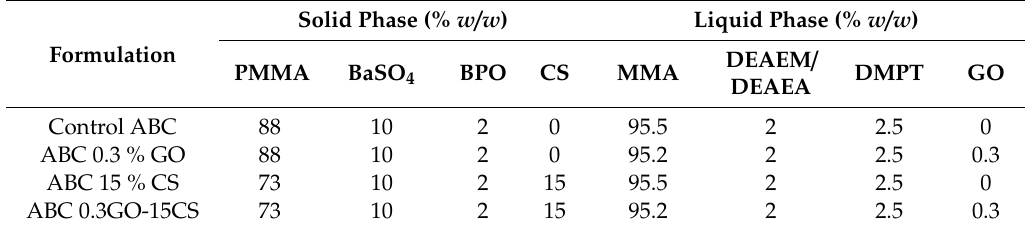
Table 2. Composition of ABCs